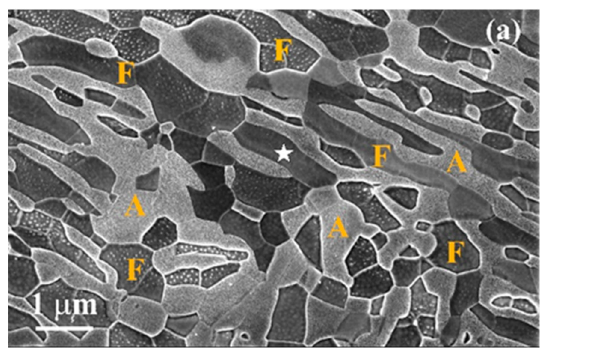
Figure 1. ( a ) SEM micrograph showing ultrafine-grained dual phase structure, consisting of ferrite and austenite, after inter-critical annealing. F: ferrite, A: austenite. ( b ) EBSD phase map of ( a ). Blue color represents fcc phase (austenite), red color represents bcc phase (ferrite), and black color represents unindexed points. White stars are registration marks.